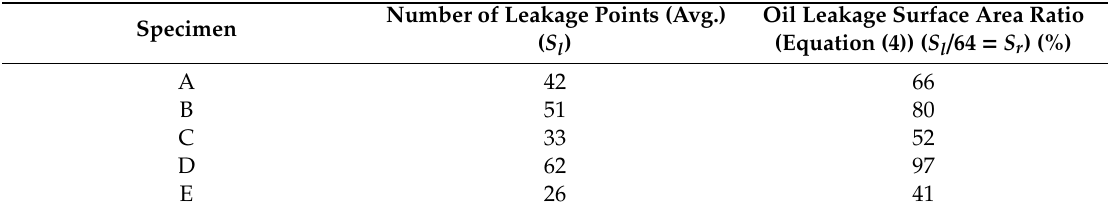
Table 18. Average oil leakage surface area calculation results.